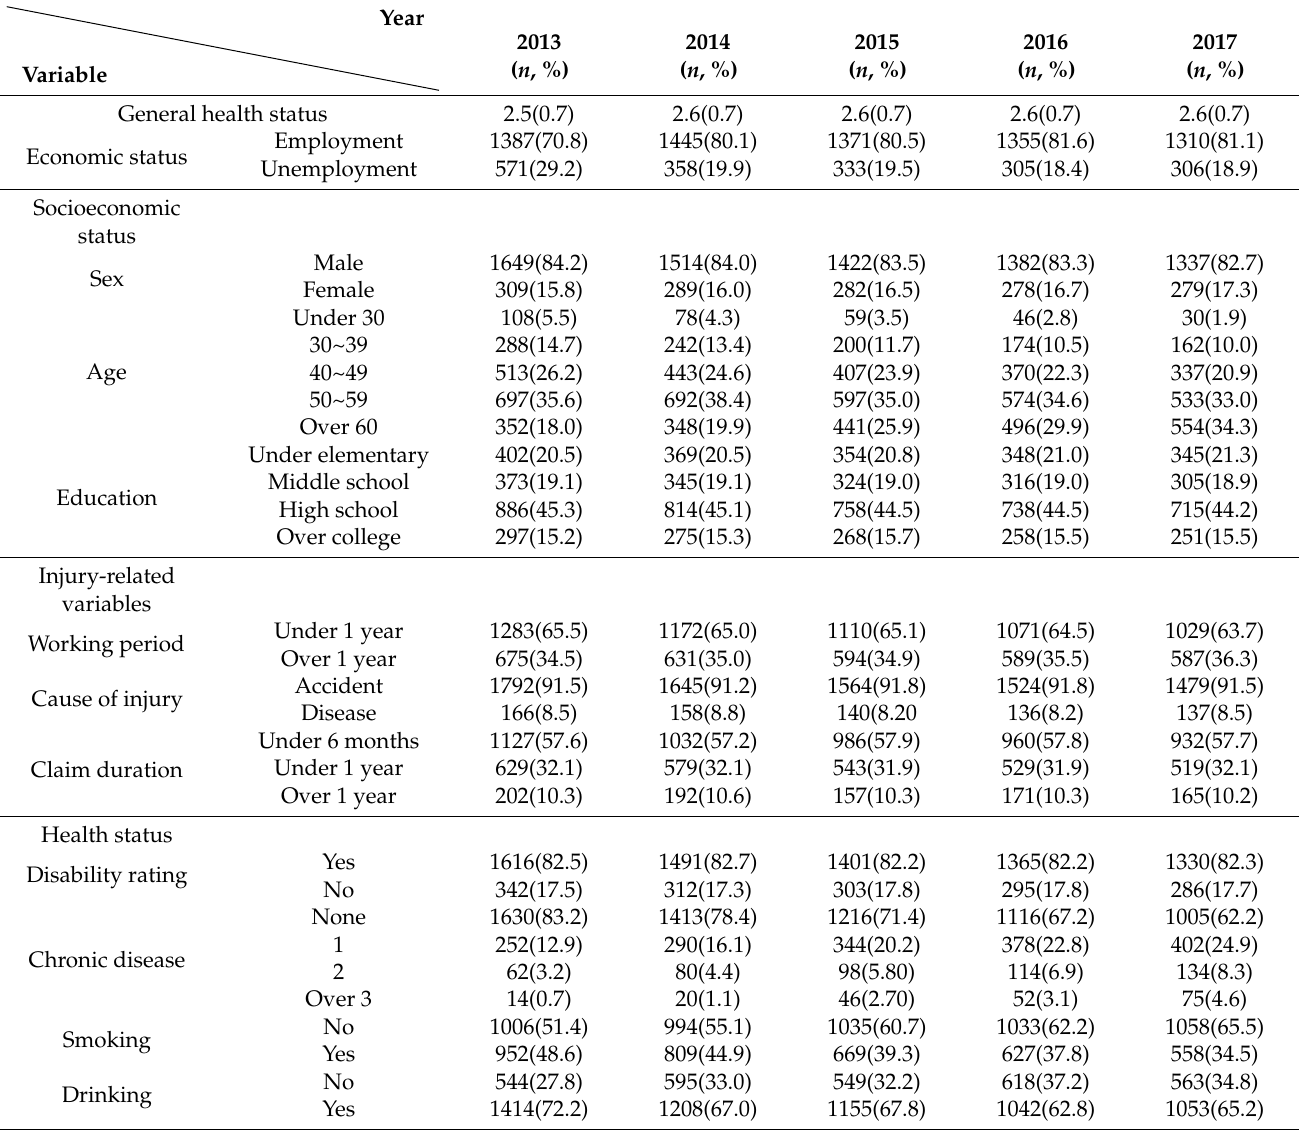
Table 1. General characteristics of workers with industrial accident